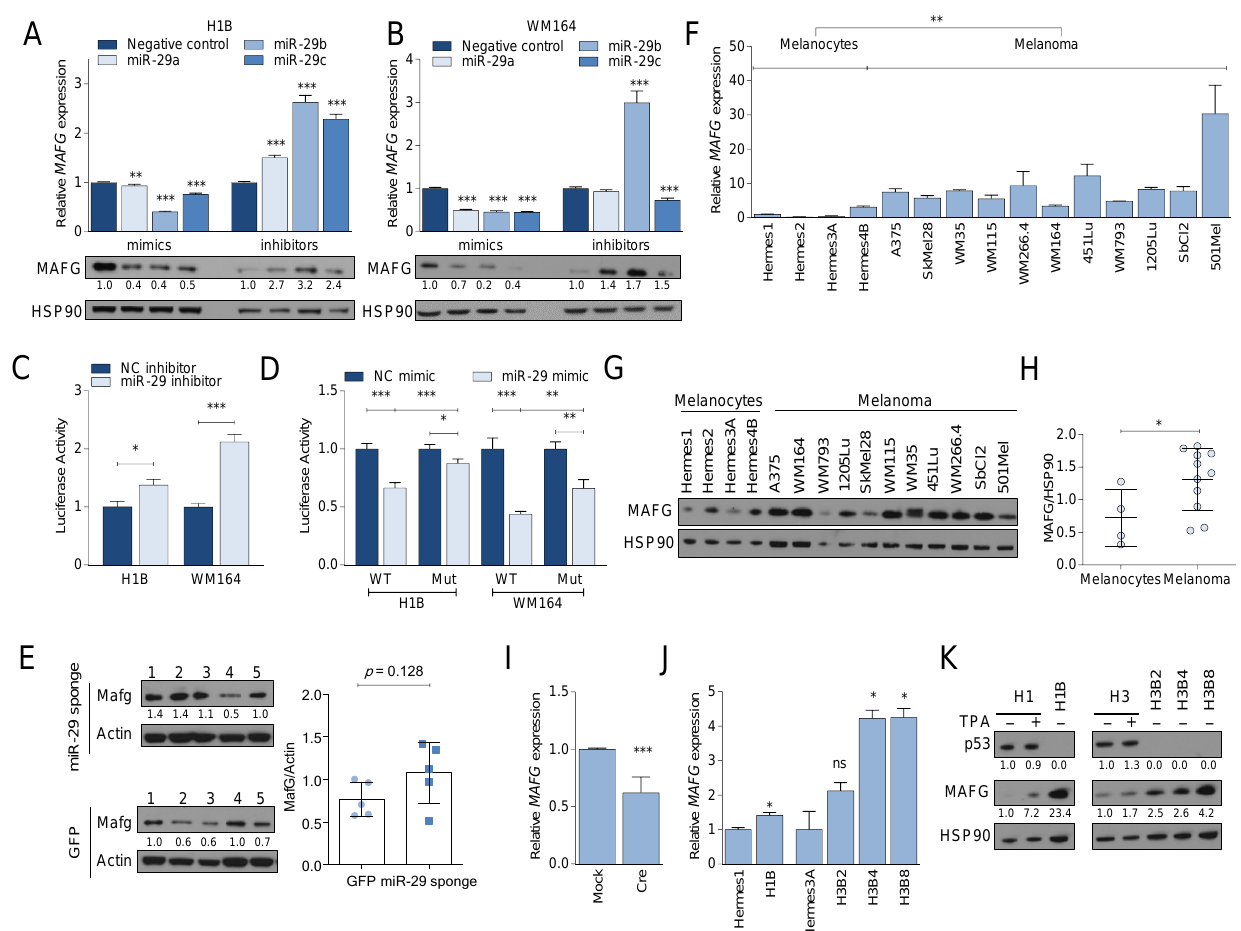
Figure 5. MAFG is a target of miR-29 and deregulated in melanoma. ( A , B ) MAFG mRNA (upper panels) and protein (lower panels) expression in response to transfection with miR-29 mimics (left) or inhibitors (right) in H1B melanocytes ( A ) or WM164 melanoma cells ( B ). The mean ± SEM of one representative out of two independent experiments performed in triplicates is shown. mRNA expression is normalized to GAPDH; ( C ) activity of MAFG 3′UTR Luciferase reporter in response to miR-29 inhibitors; ( D ) activity of MAFG wildtype or miR-29 binding site-mutant 3′UTR Luciferase reporter in response to miR-29 mimics. For ( C , D ), the combined mean ± SEM of two independent experiments performed in quadru- plicates is shown; ( E ) Western blot showing MAFG expression in GFP and miR-29 sponge melanomas isolated from Braf V600E ; Pten /WT chimeras; ( F ) qRT-PCR showing the basal expression levels of MAFG mRNA in melanocytes and mela- noma cells. The mean ± SEM of one representative out of two independent experiments performed in triplicates is shown. Expression is normalized to GAPDH; ( G ) Western blot showing the expression levels of MAFG protein in melanocytes ( n = 4) and melanoma cells ( n = 11); ( H ) Quantification of the Western blot shown in ( G ); ( I ) qRT-PCRs showing the expression of MAFG in LSL-Braf V600E PMM following Adeno-Cre/Mock infection; ( J ) qRT-PCR showing the expression levels of MAFG mRNA in parental and BRAF V600E -mutant melanocytes. The mean ± SEM of one representative out of two independent experiments performed in triplicates is shown. Expression is normalized to GAPDH; ( K ) Western blot showing MAFG expression in human melanocytes in response to TPA stimulation or chronic BRAF V600E expression. The mean ± SEM of one representative out of two independent experiments performed in triplicates is shown. All Western blots show the intensity ratio of the protein of interest normalized to HSP90 or Actin. * p < 0.05; ** p < 0.01; *** p < 0.001.